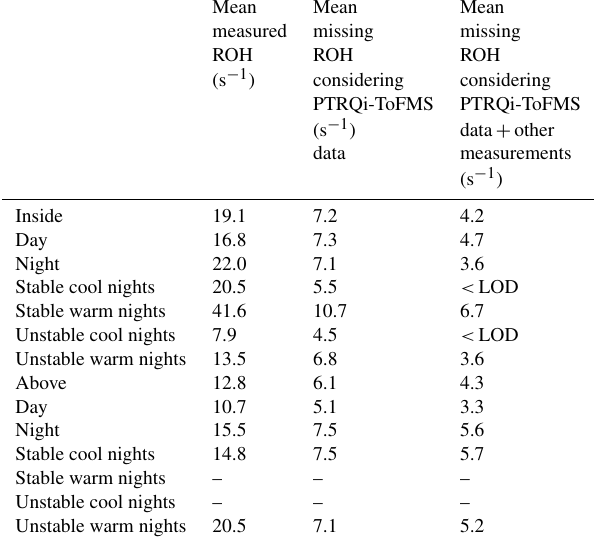
Table 4. Summary of the measured OH reactivity and the missing OH reactivity inside and above the canopy during the day and the night, taking into account only PTR-MS data or all the data avail- able at each height for OH reactivity calculations. These averages are calculated for the periods when CRM, PTR-MS and other in- strumental data are available.